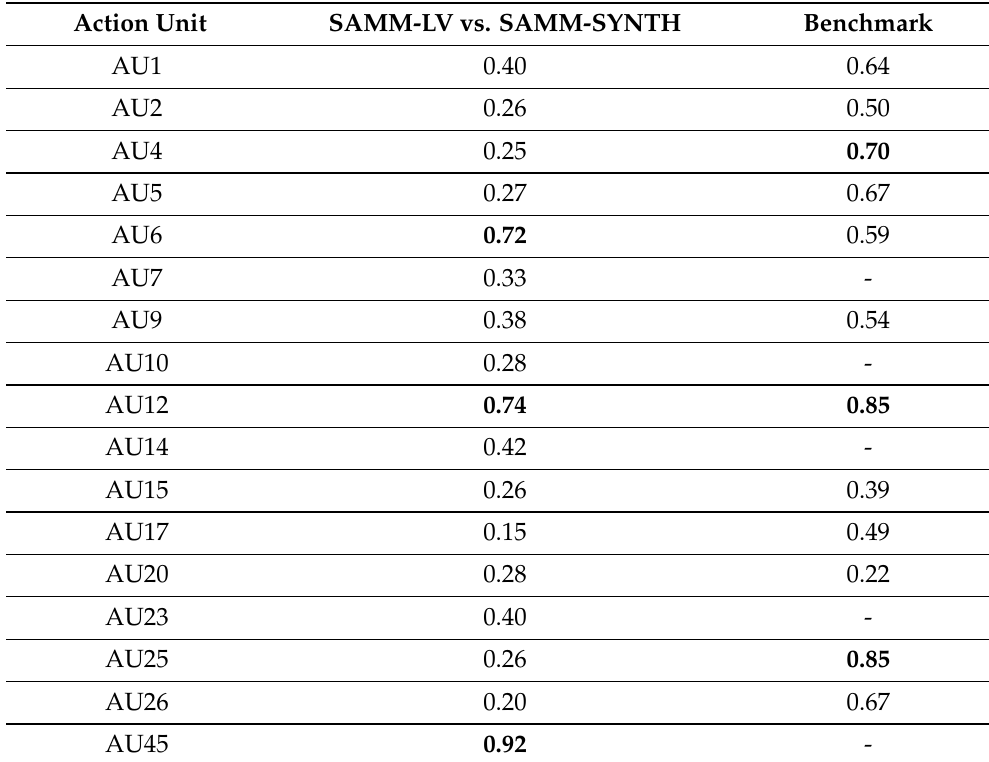
Table 1. Analysis of Action Units (AUs) detected by OpenFace on original SAMM-LV participants and SAMM-SYNTH synthetic videos. The bolded values are the top-3 highest Pearson’s correlation coefficients. Pearson’s correlation coefficients show strong positive correlation for AU6, AU12, and AU45, which are well preserved compared to the other AUs. “Benchmark” indicates the Pearson’s coefficients of OpenFace detection versus ground truth labelling on DISFA dataset [36], which reported that OpenFace has better performance on AU4, AU12, and AU25